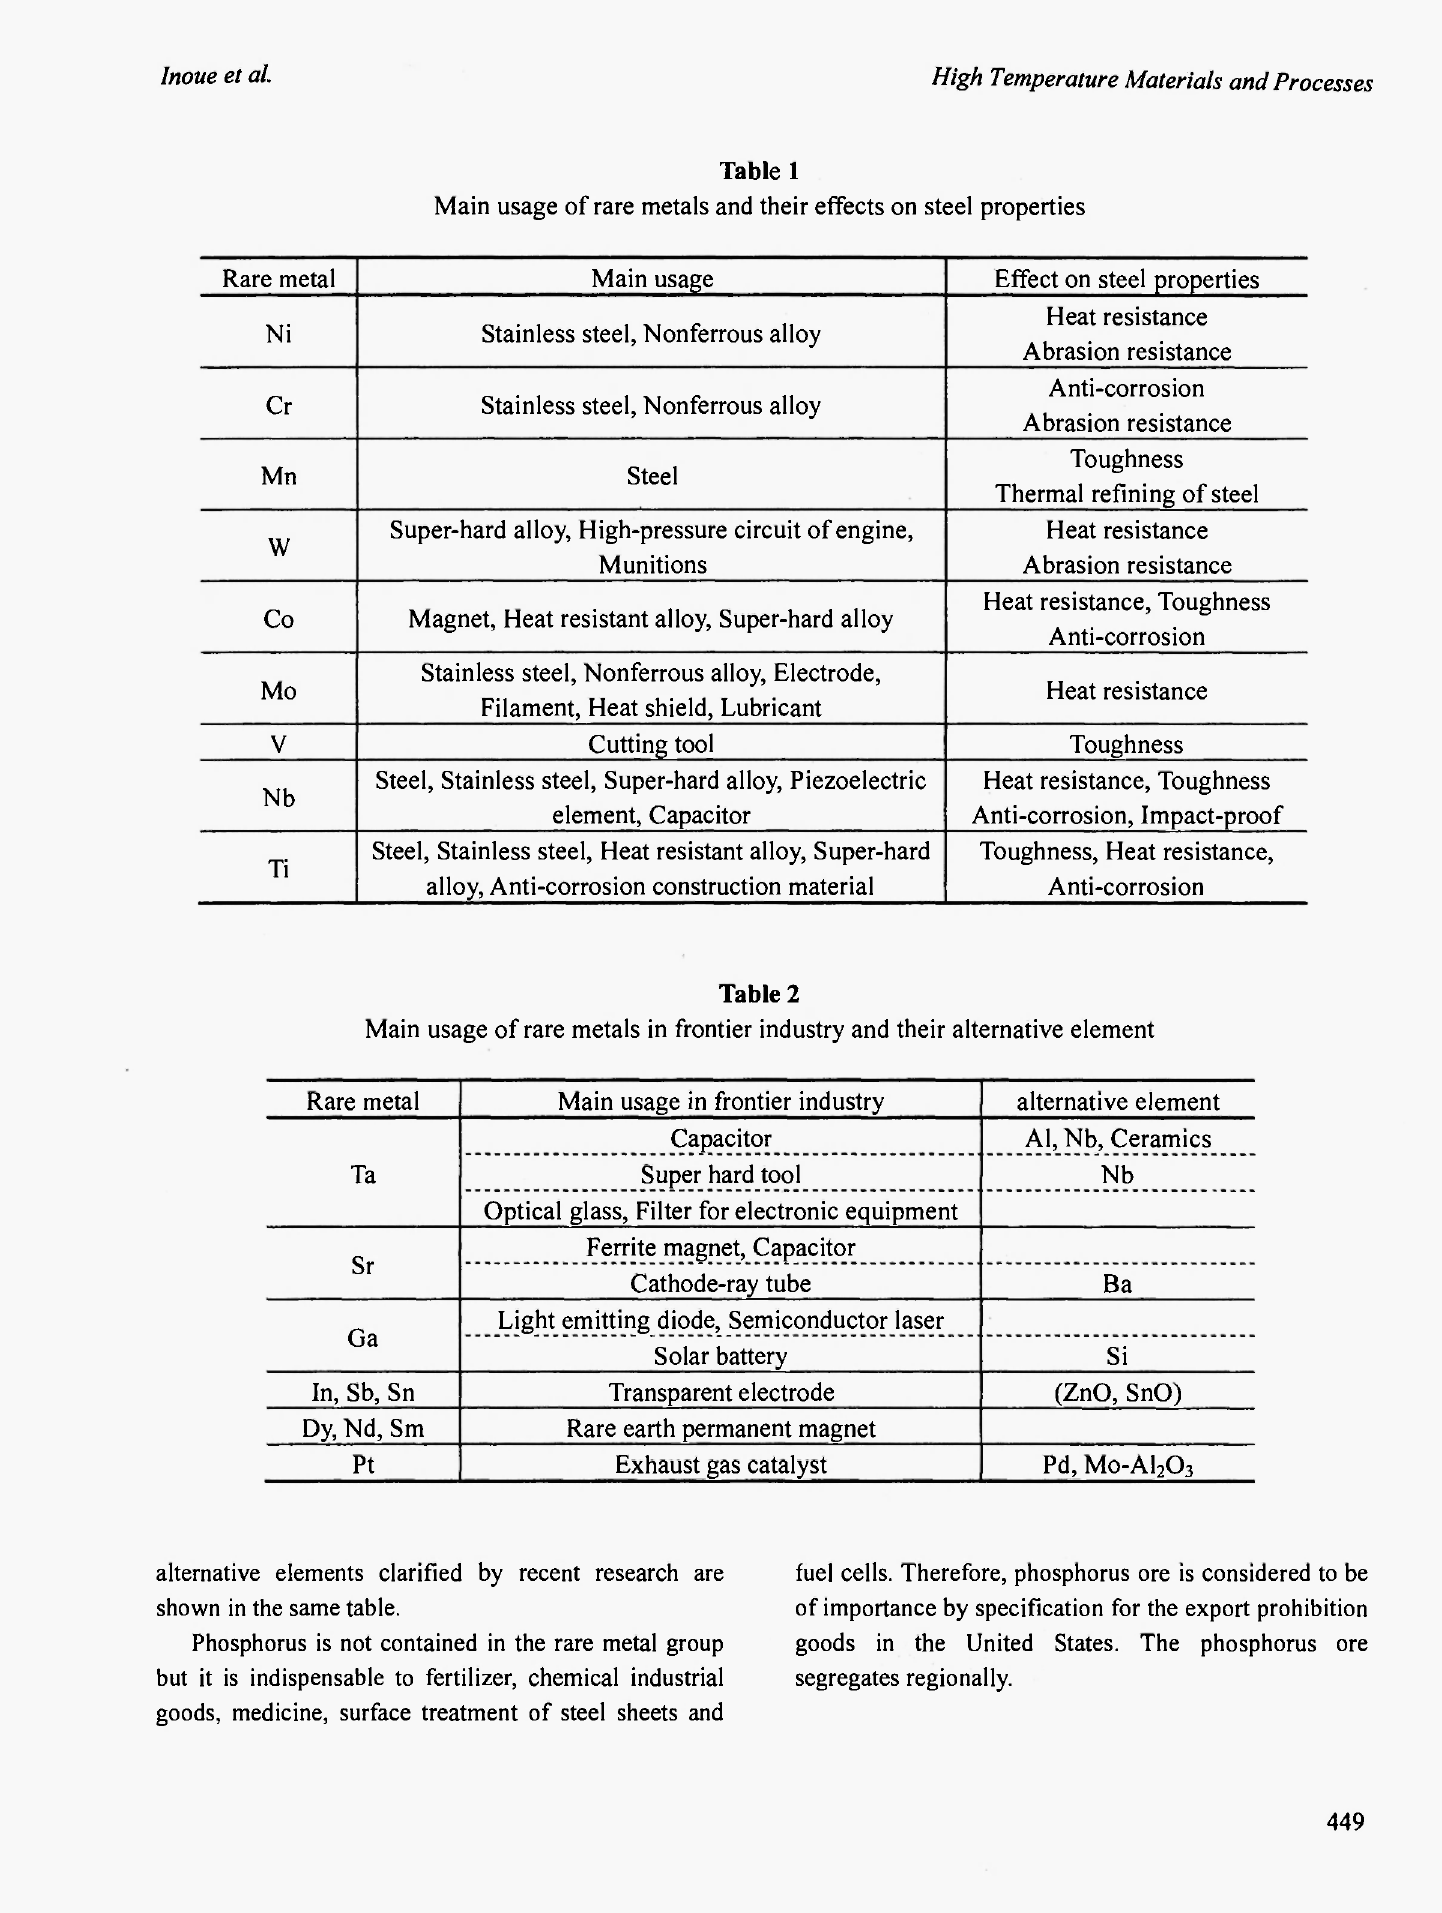
Main usage of rare metals and their effects on steel properties